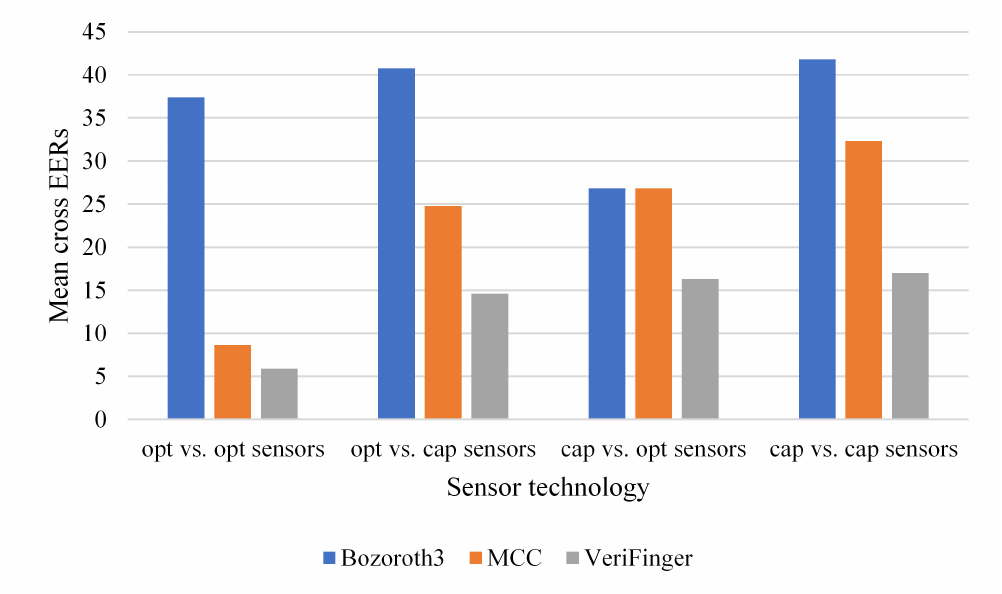
Figure 9. Mean cross EERs of the three methods for the sensor technology types; opt and cap indicate optical and capacitive sensors,